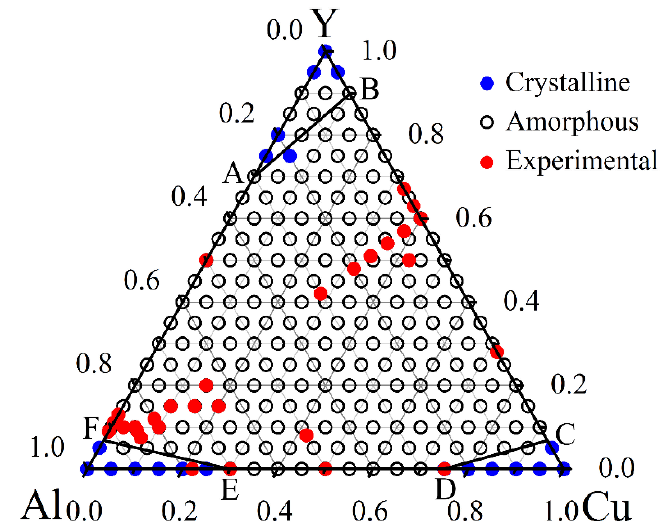
Figure 1. The hexagonal glass formation region, enclosed by ABCDEF, that are located by the thermodynamic calculations for the ternary Al-Cu-Y